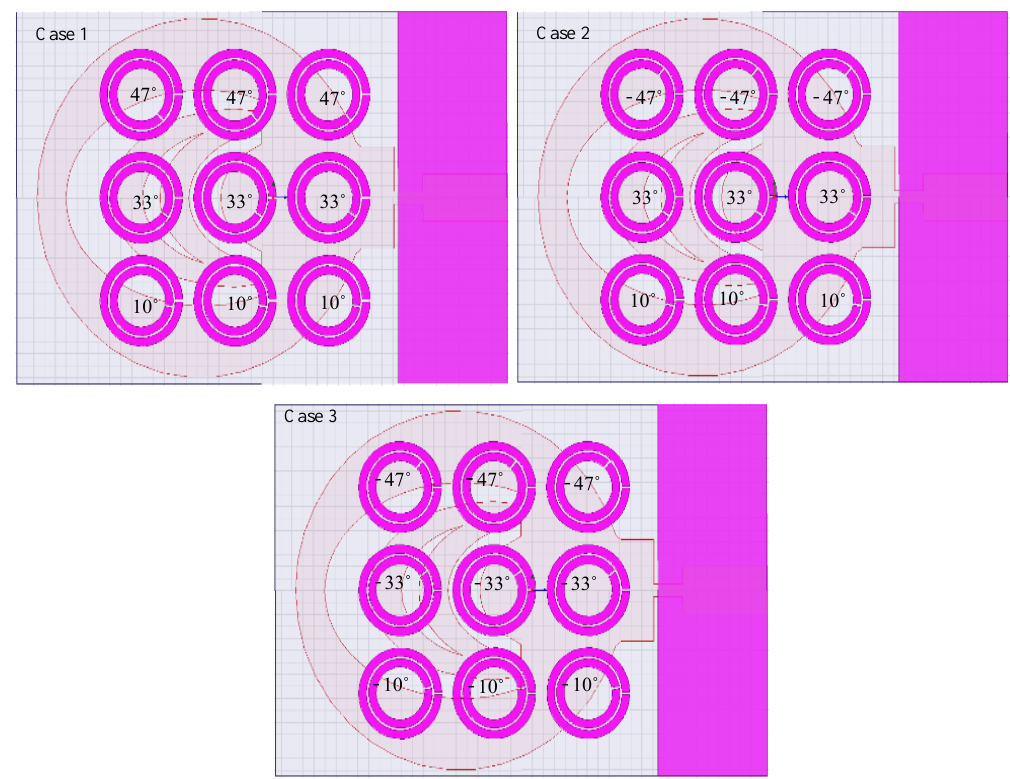
Figure 31. C – SRRs inner ring rotation for positive and negative angle.